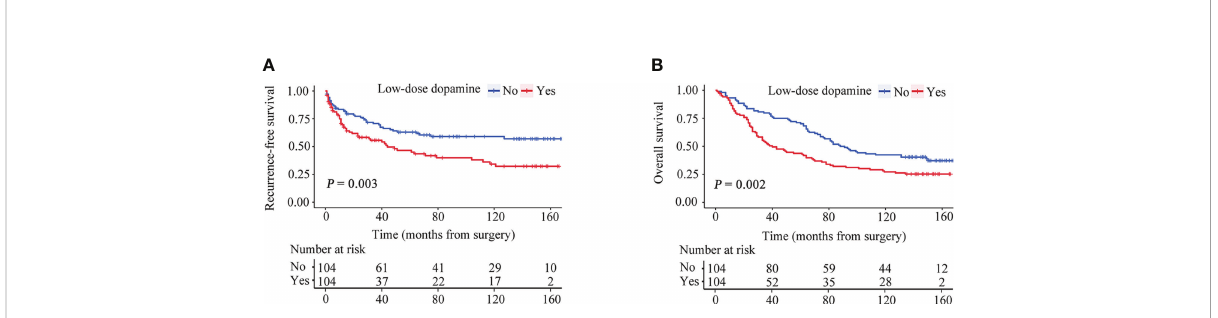
FIGURE 3 Recurrence-free survival (RFS) and overall survival (OS) curves strati fi ed by dose of dopamine after propensity score matching. (A) RFS curves. (B) OS